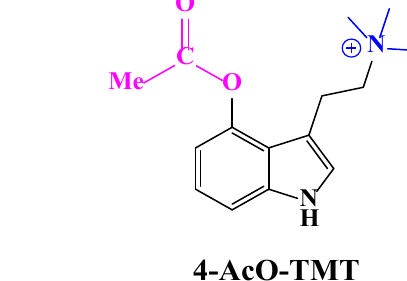
Figure 2. Aeruginascin analog (4-AcO-TMT).